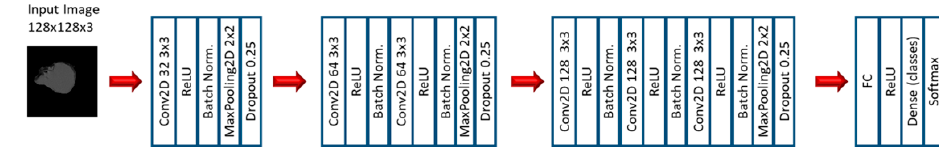
Figure 3. Architecture 1 of CNN base models.